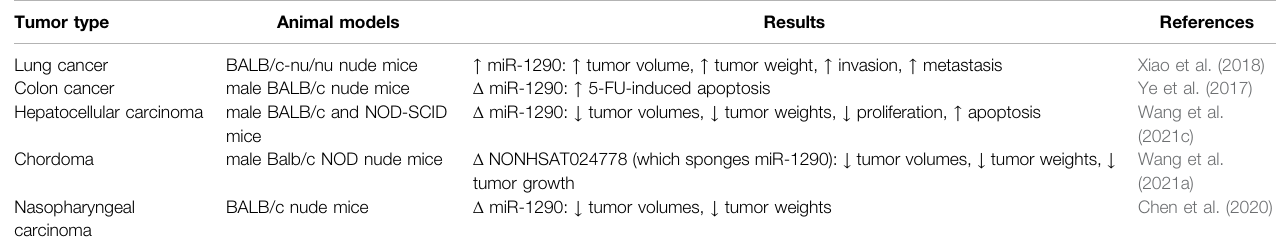
TABLE 2 | Impact of miR-1290 in carcinogenesis based on investigations in animal models ( Δ : knock-down or